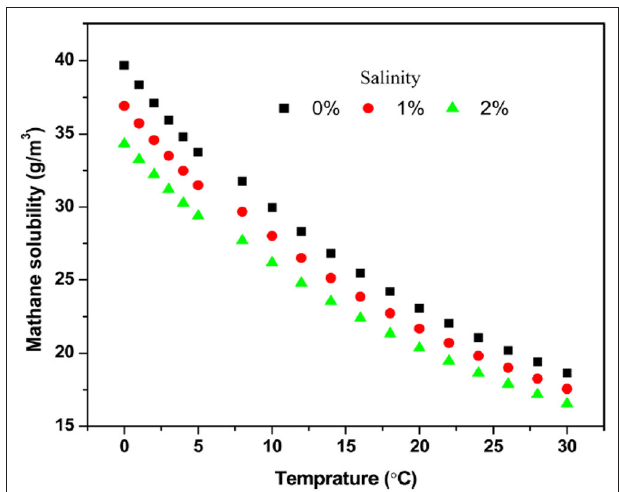
FIGURE 1 | Solubility of methane in water under different temperature and salinity (Adapted with permission from Dissolved Methane: A Hurdle for Anaerobic Treatment of Municipal Wastewater Liu et al., 2014. Copyright 2014 American Chemical